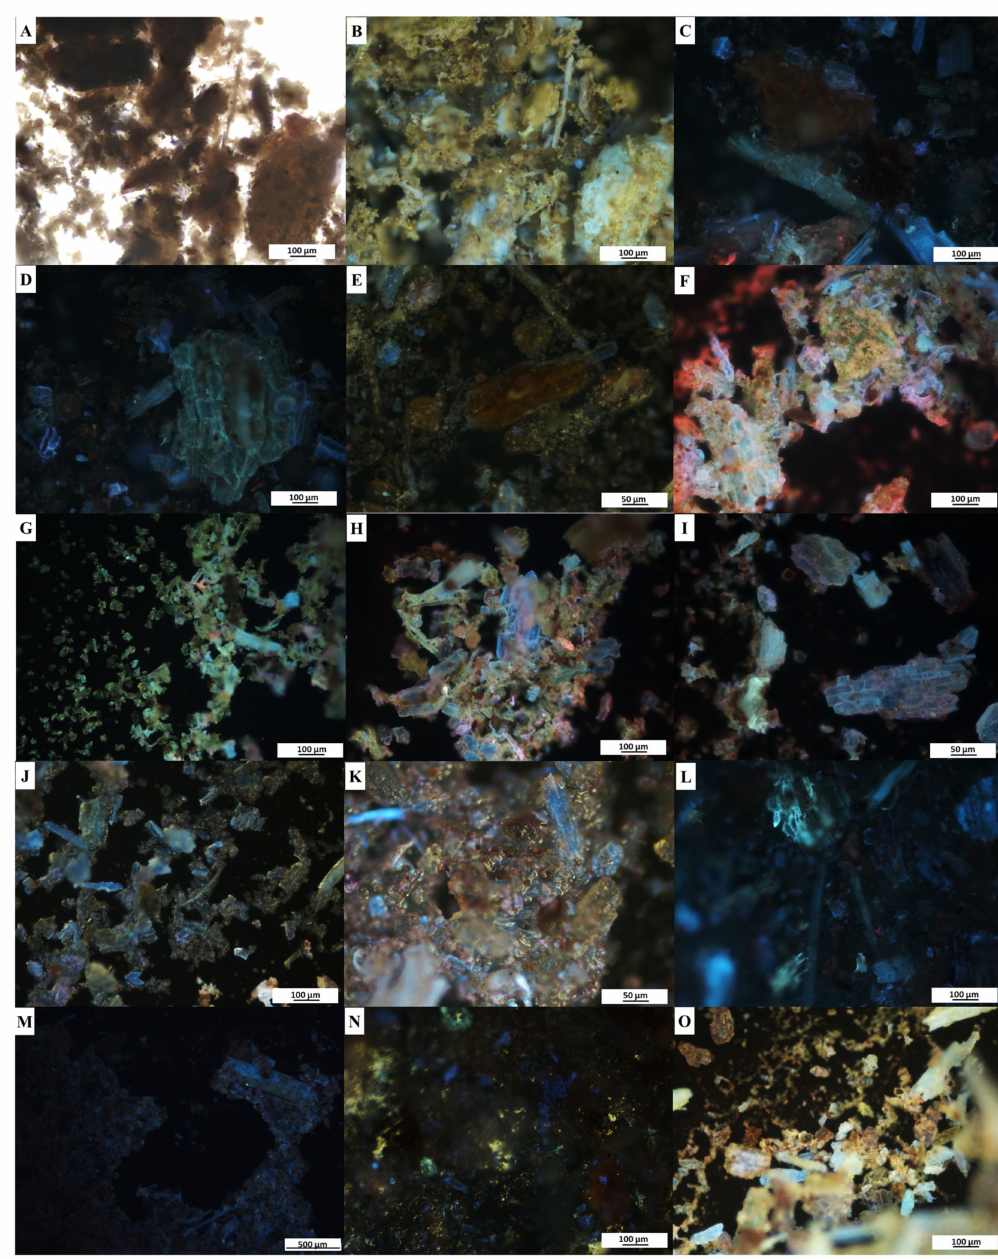
Figure 4. Fluorescence microanalyses of powdered stem material of Combretum molle . Powder only under ( A ) brightfield and ( B ) UV light (control); powder treated with: ( C , D ) distilled water; ( E ) hexane; ( F ) chloroform; ( G ) methanol; ( H , I ) ethanol; ( J , K ) acetic acid; ( L ) sodium hydroxide; ( M ) sulphuric acid; ( N ) hydrochloric acid; and ( O ) acetone under UV